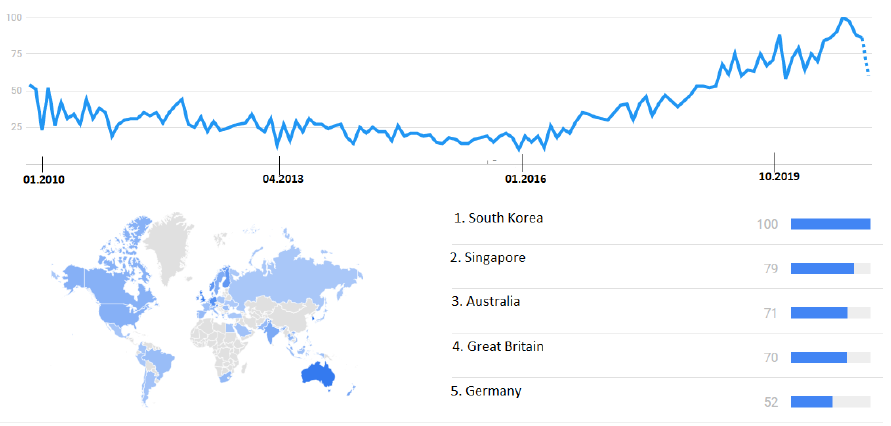
Figure 5. Global extent of interest in the term “digital twin” (concerns the period 1 Jan 2010–12 Jan